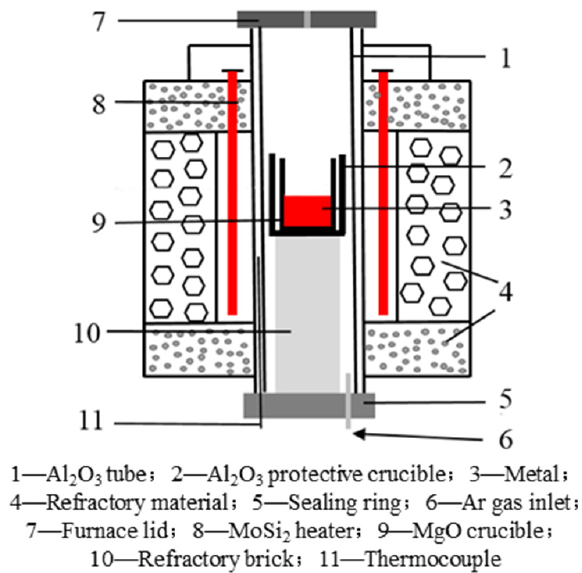
Figure 1. Schematic of silicon molybdenum resistance furnace [29]. Table 1. Target composition of spring steel and chemical composition of Si-Ca-Ba-compounded deoxidizer/wt.%.